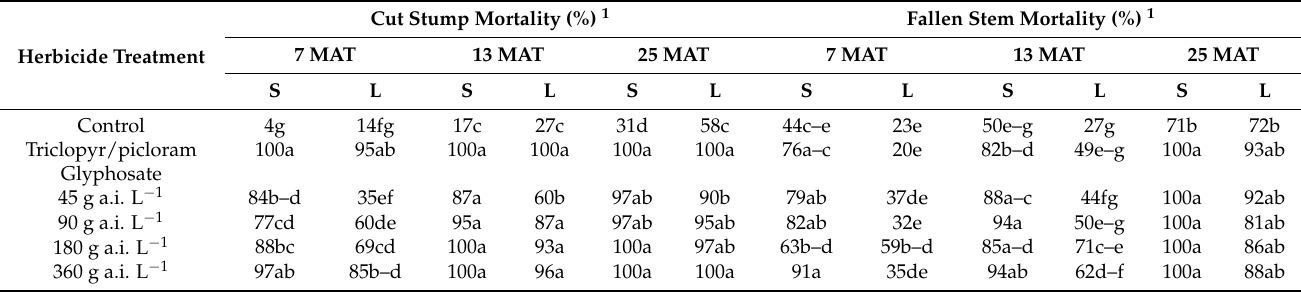
1 Means within an assessment time that do not share a letter are significantly different ( p < 0.05) according to Fisher’s LSD